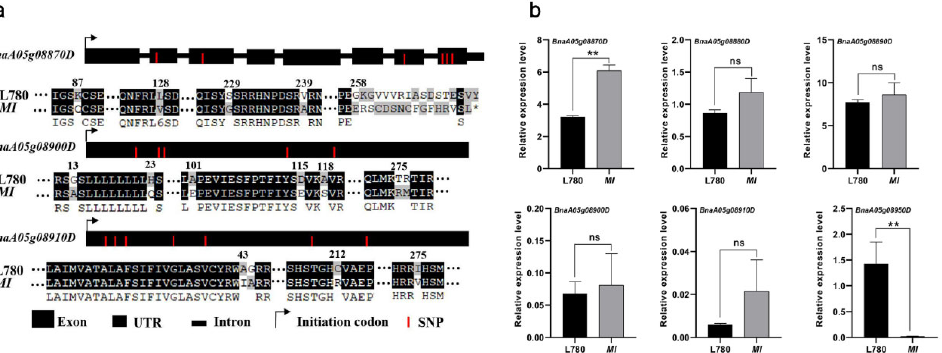
Figure 4. Gene structure, protein alignment, and expression analysis of the candidates. ( a ) Gene structures and variations between alleles from L780 and MI . The asterisk symbolizes the terminator, numbers represent the location of amino acids and apostrophes indicate omitted amino acids; ( b ) Relative expression of candidates in shoot apical meristem (SAM). Student’s t test was used for statistical analysis; values are the mean ± standard deviation (SD) of three biological replicates ( ** p < 0.01, ns indicated no significant difference).